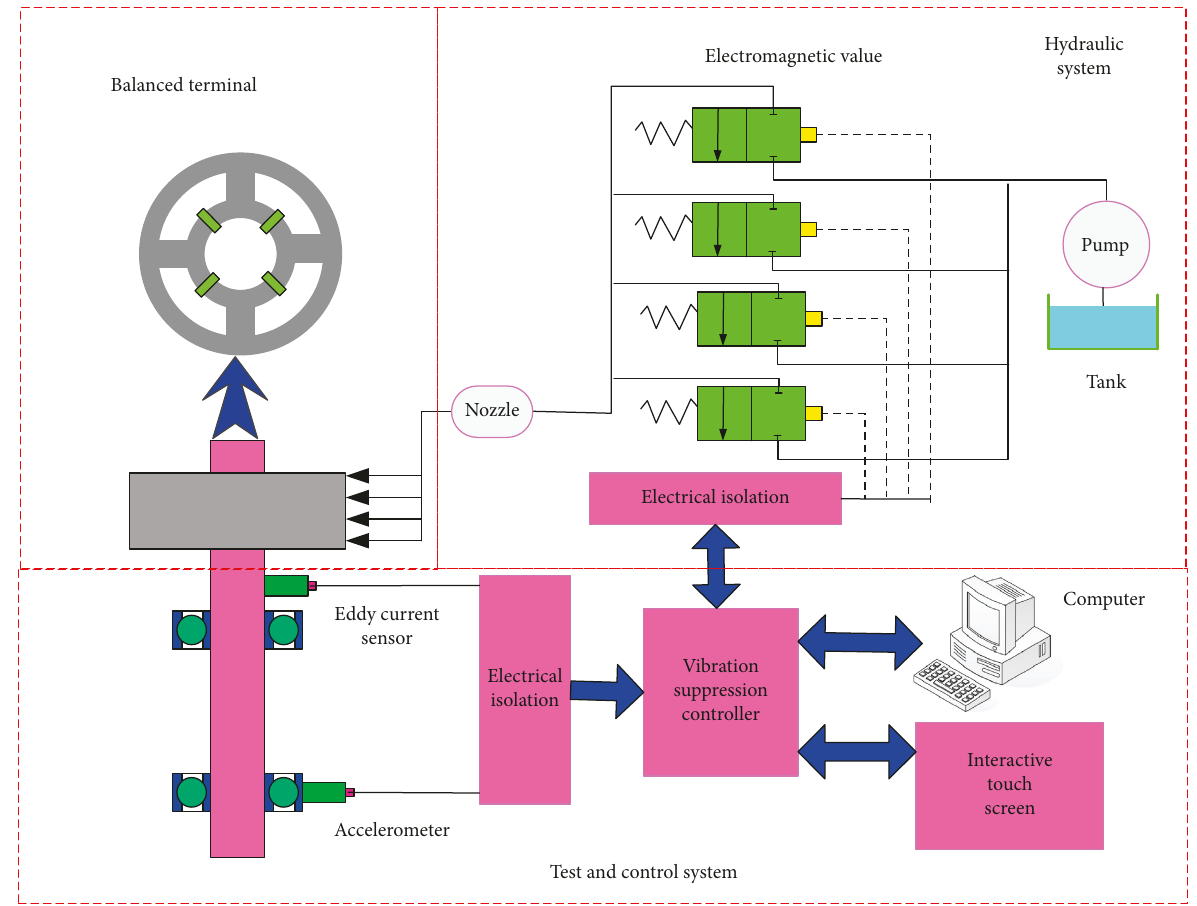
Figure 4: Spray online balance system